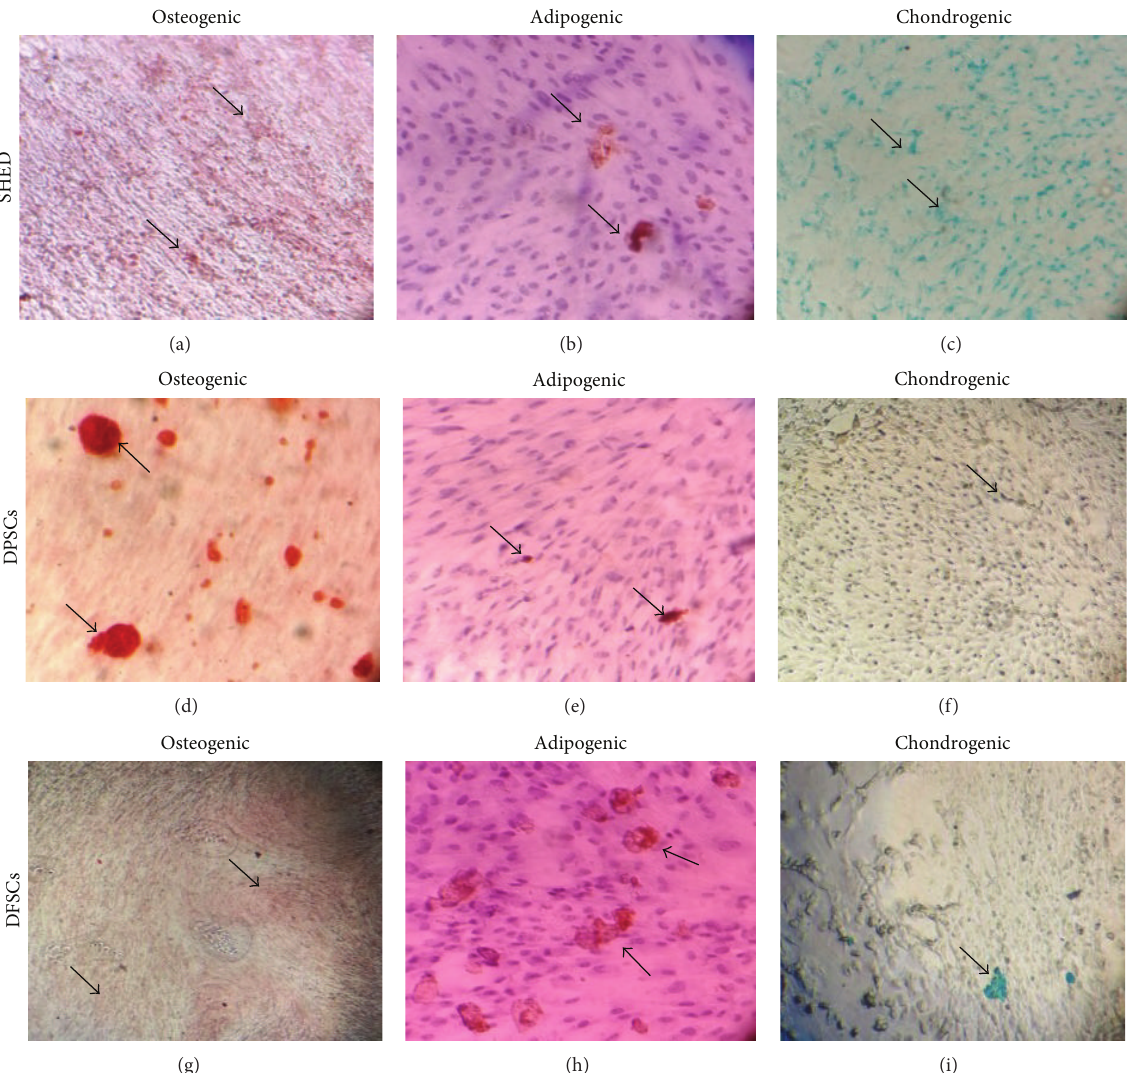
Figure 3: Differentiation analysis in SHED, DPSCs, and DFSCs. (a, d, g) Alizarin red staining of osteogenic induced SHED, DPSCs, and DFSCs. (b, e, h) Oil Red staining of adipogenic induced SHED, DPSCs, and DFSCs. (c, f, i) Alcian blue staining of chondrogenic induced SHED, DPSCs, and